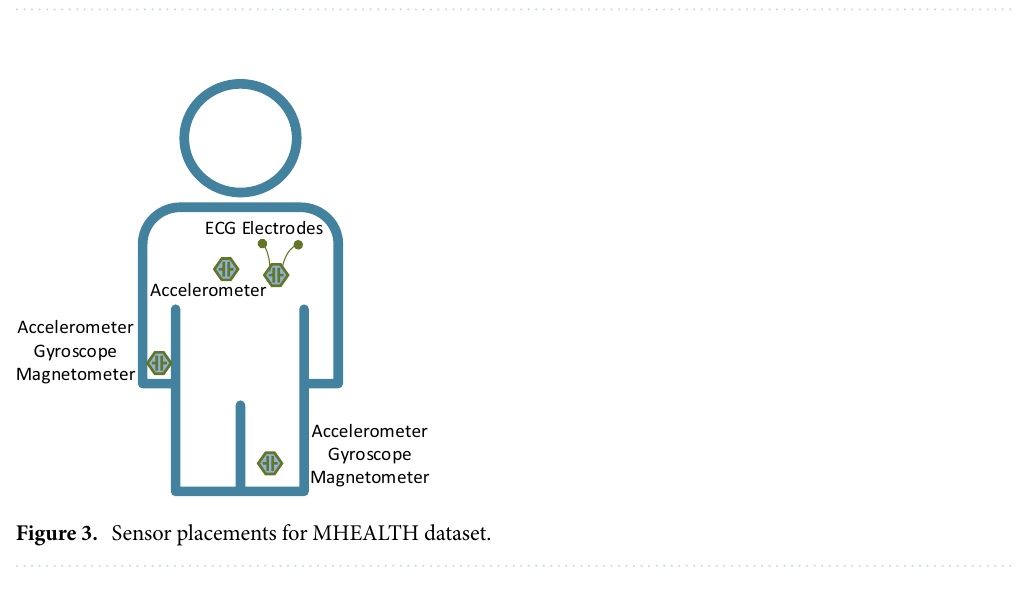
Figure 2. Flowchart of training and testing process of the proposed method.